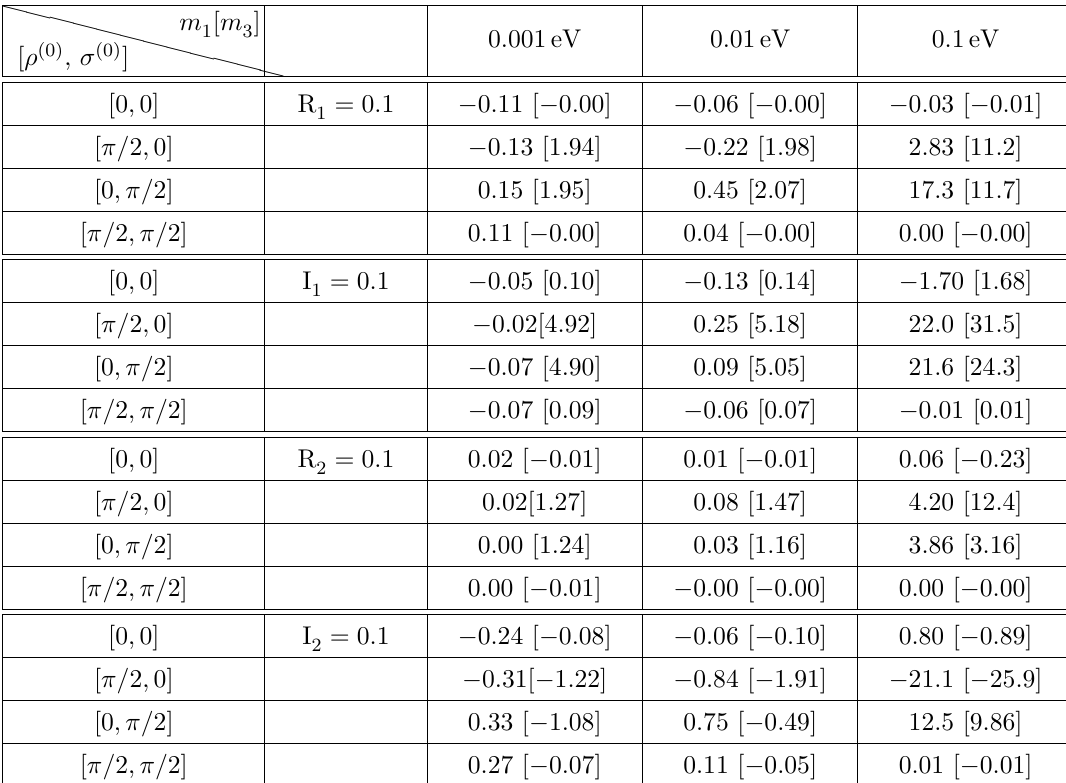
Table 2 . Some representative values of (cid:1) (cid:14) (induced by R respectively) at m